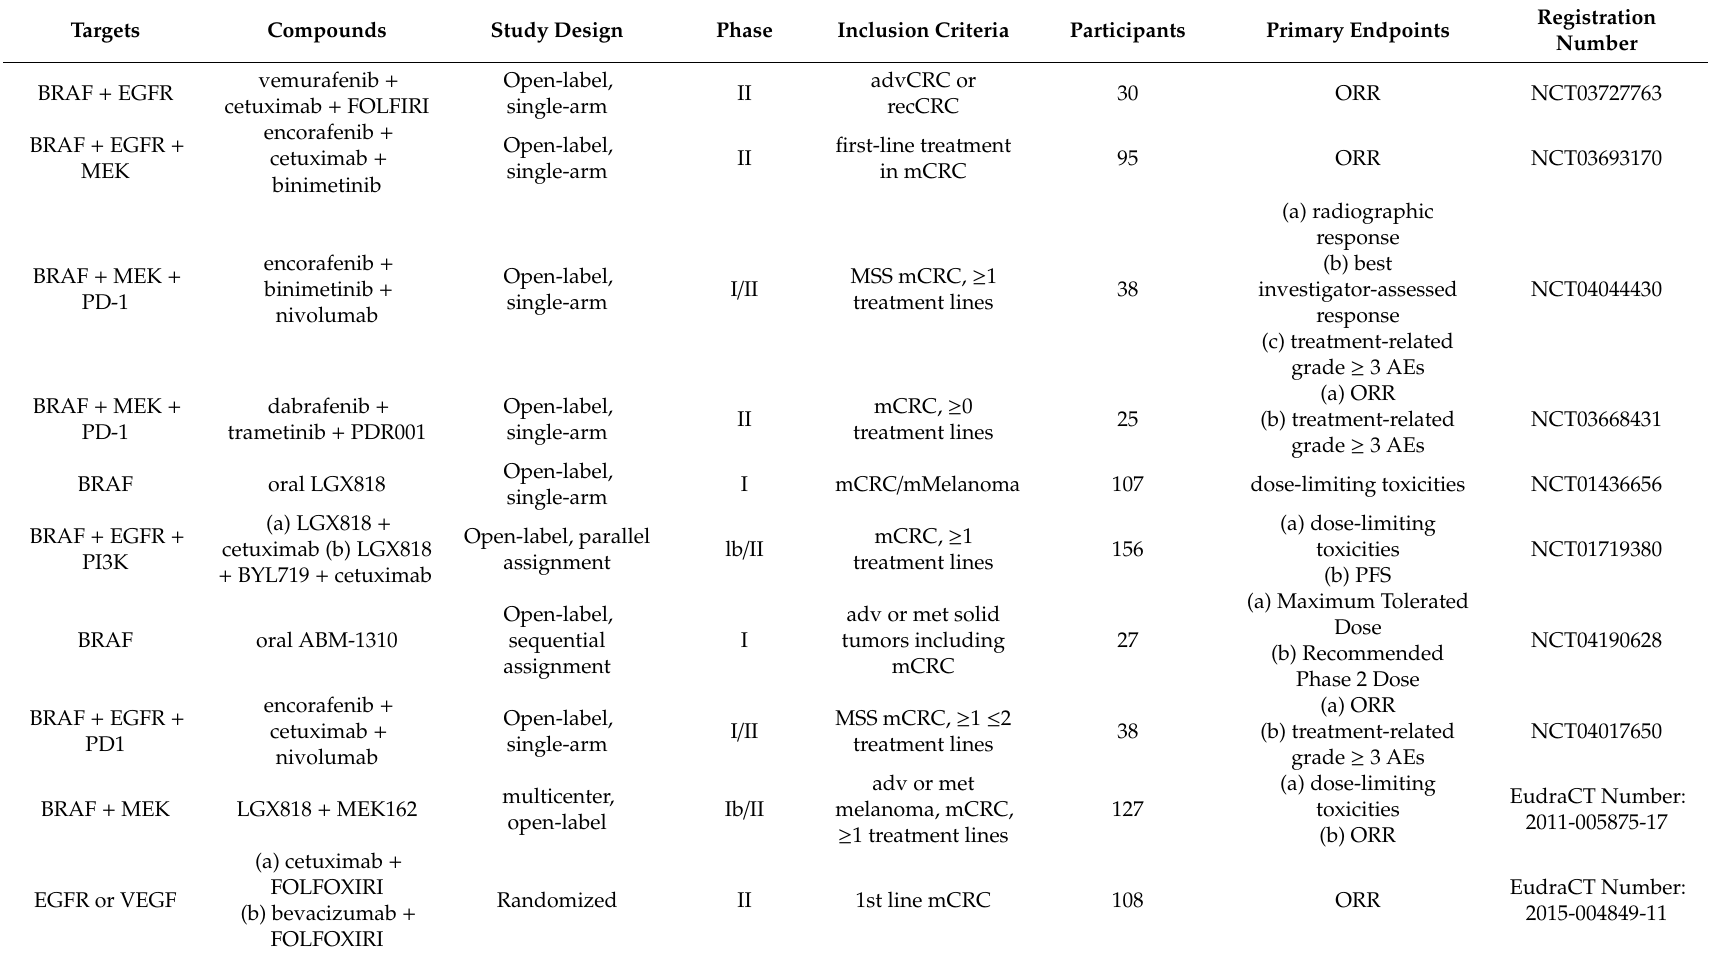
Table 1. Summary of current ongoing trials including patients with BRAF